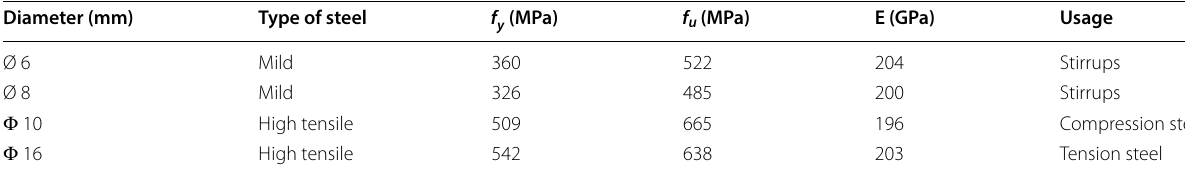
Table 1 Mechanical properties of the steel reinforcement. Diameter